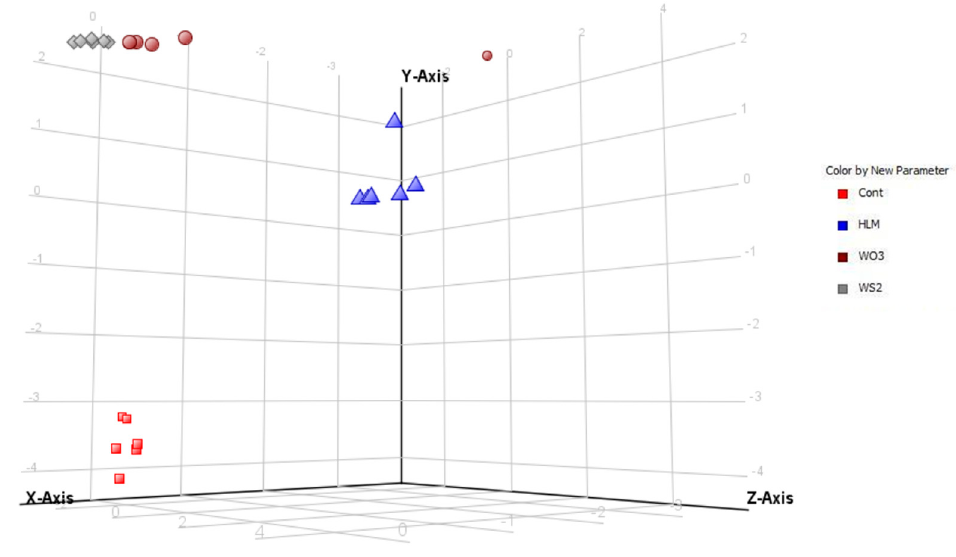
Figure 2. PCA plot of HLM (blue triangles), WS 2 (grey diamonds), and WO 3 (brown spheres) with the control group (red squares) profiles of molindone.